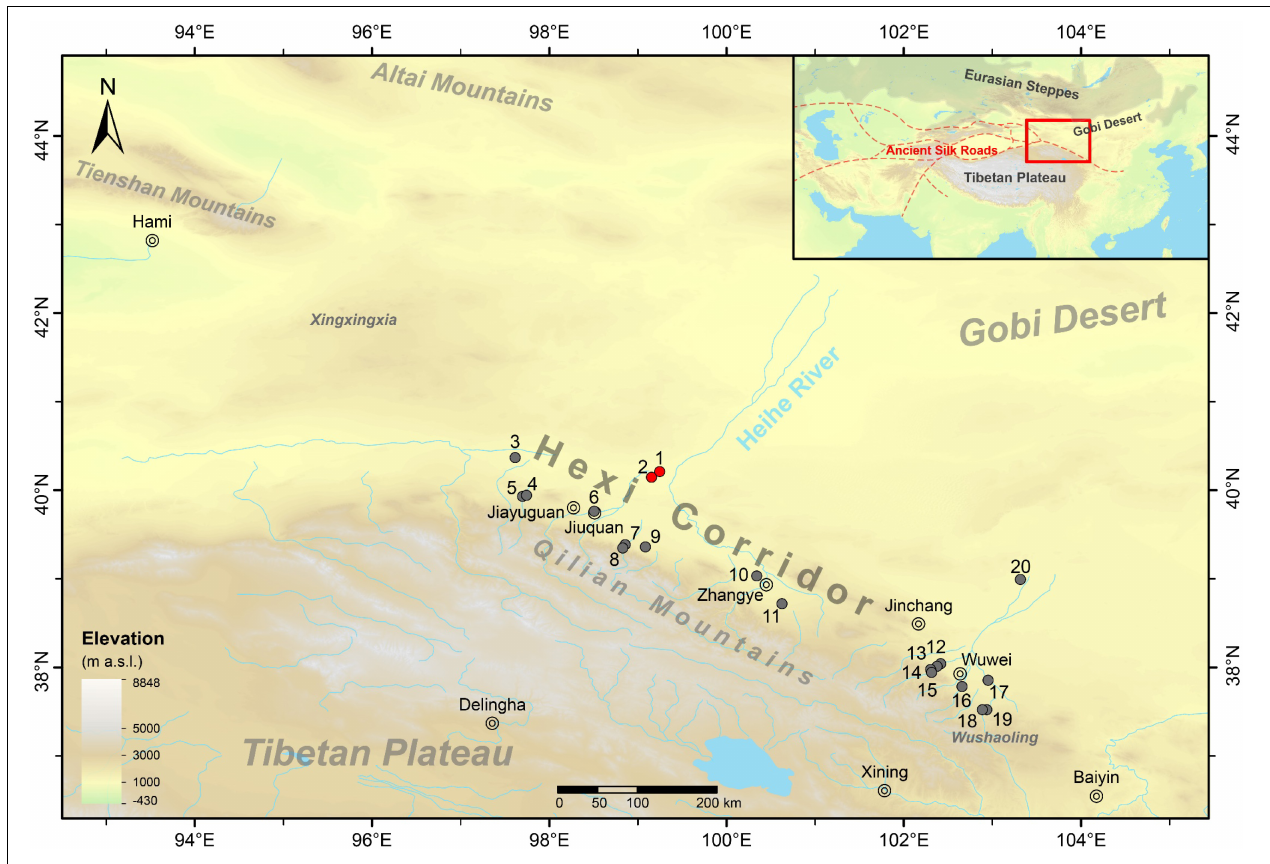
FIGURE 1 | Regional map showing the geographic location of Hexi Corridor and its positional relation with neighboring geographic units. The prehistoric archeological sites mentioned in this paper are labeled in red (this study) and gray (previous studies) dots as (1) Huoshiliang; (2) Ganggangwa; (3) Gudongtan; (4) Huoshaogou; (5) Dadunwan; (6) Zhaojiashuimo; (7) Ganguya; (8) Sanbadongzi; (9) Xihetan; (10) Xichengyi; (11) Xihuishan; (12) Guojiashan; (13) Xinzhai; (14) Qipanshan; (15) Shichengshan; (16) Mozuizi; (17) Tuba; (18) Lijiageleng; (19) Shuikou; and (20)